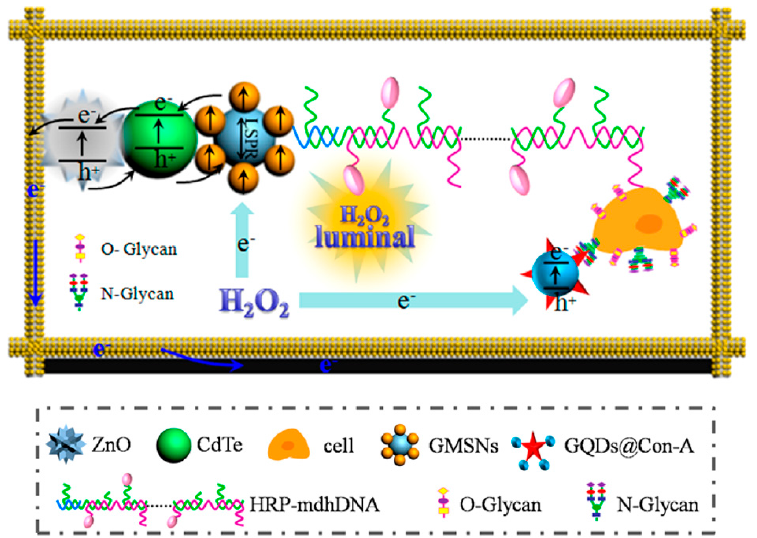
Figure 7. Analytical principle of photoelectrochemical biosensor based on ConA − GQDs. Reprinted with permission from ACS Applied Materials & Interfaces, ref. [116]. Copyright (2017) American Chemical Society.